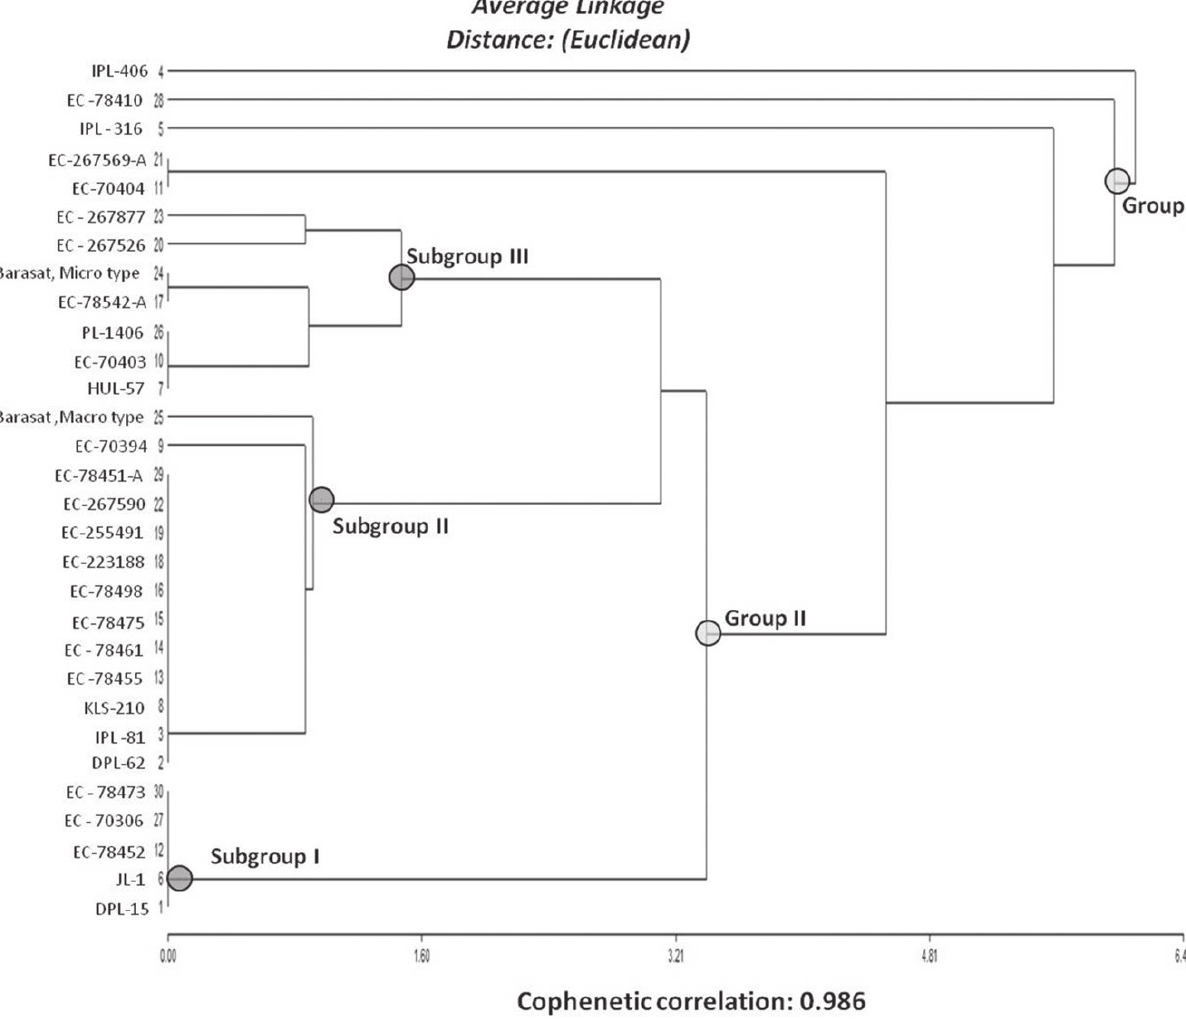
Figure 6. UPGMA dendrogram derived from average Euclidean distance based on fluorochrome banding pattern of 30 Indian Lentil culti- vars, cultivar names in the left of their serial